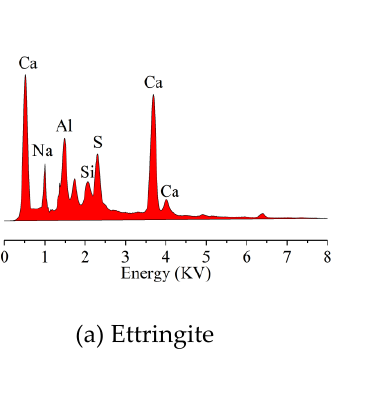
Figure 20. EDS energy spectrum image.